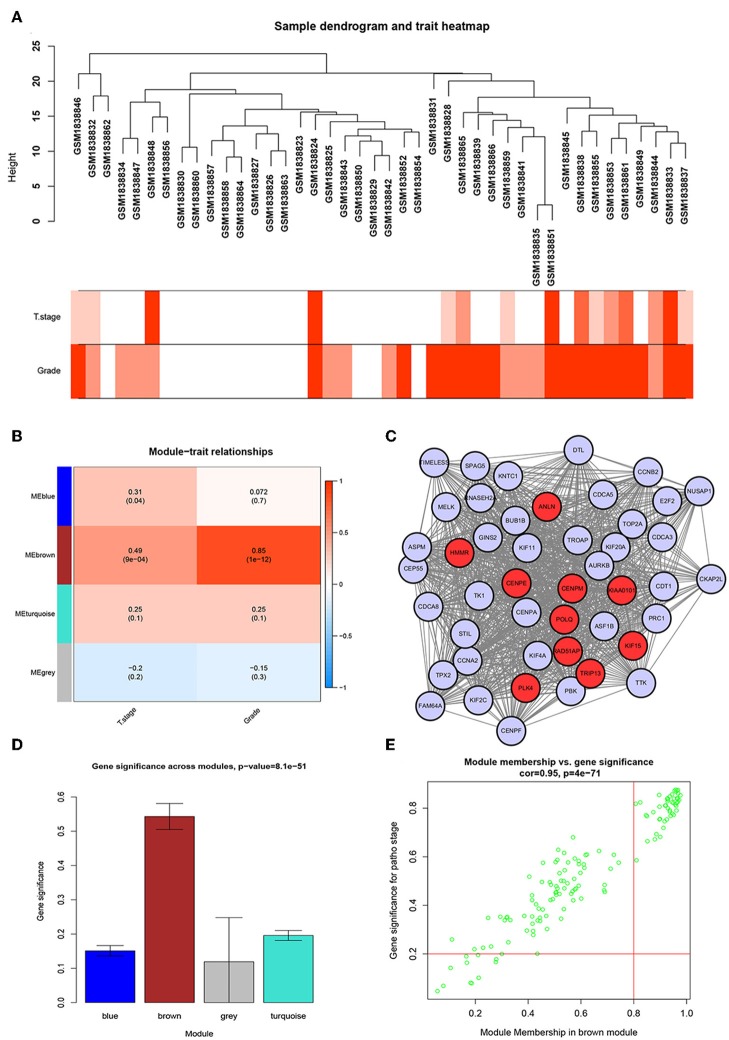
WGCNA and PPI network analysis. (A) Sample dendrogram and trait indicator. The clustering was a visual result of calculations based on Pearson correlation coefficients between samples. The color intensity was proportional to T stage and histologic grade of BC. (B) Identification of modules associated with the clinical traits of BC. (C) PPI network of WGCNA hub genes, the red nodes represent the hub genes in the PPI network. (D) Distribution of average gene significance and errors in the modules associated with histologic grade of BC. (E) Scatter plot of module eigengenes related to histologic grade in the brown module.